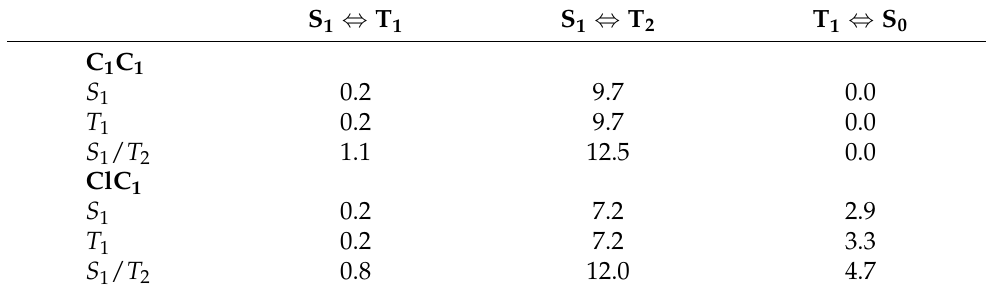
Table 6. The largest spin–orbit coupling elements between the relevant singlets and triplets in cm − 1 at the S 1 and T 1 TD-DFT minima, and at the minimum-energy (CAS(14,10)/ANO-RCC-VDZP) S 1 / T 2 crossing. The spin–orbit coupling elements are calculated at the MS-CASPT2(14,10)/ANO-RCC- VTZP level, state-averaging over the lowest three roots for singlets, and the first two roots for the